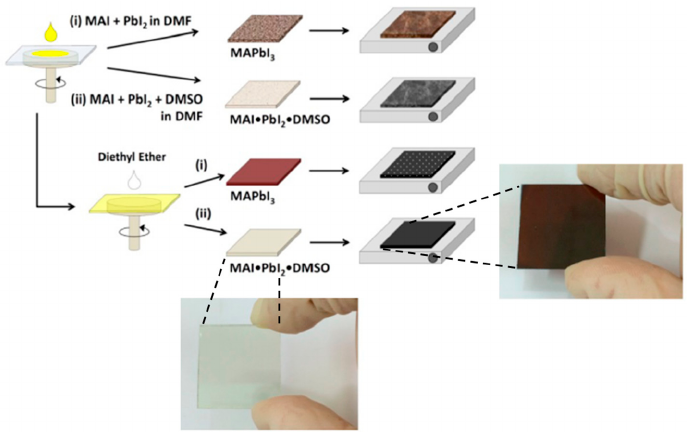
Figure 3. Schematic representation of the anti-solvent (DE) dripping method when incorporating or not DMSO as a co-solvent in the perovskite precursor solution. Macroscopical photos of the films in the intermediate (transparent) and perovskite phase (dark brown) are also shown. Perovskite is formed after annealing at 65 °C for 1 min and then at 100 °C for 2 min. [25]. Copyright (2015) American Chemical Society.